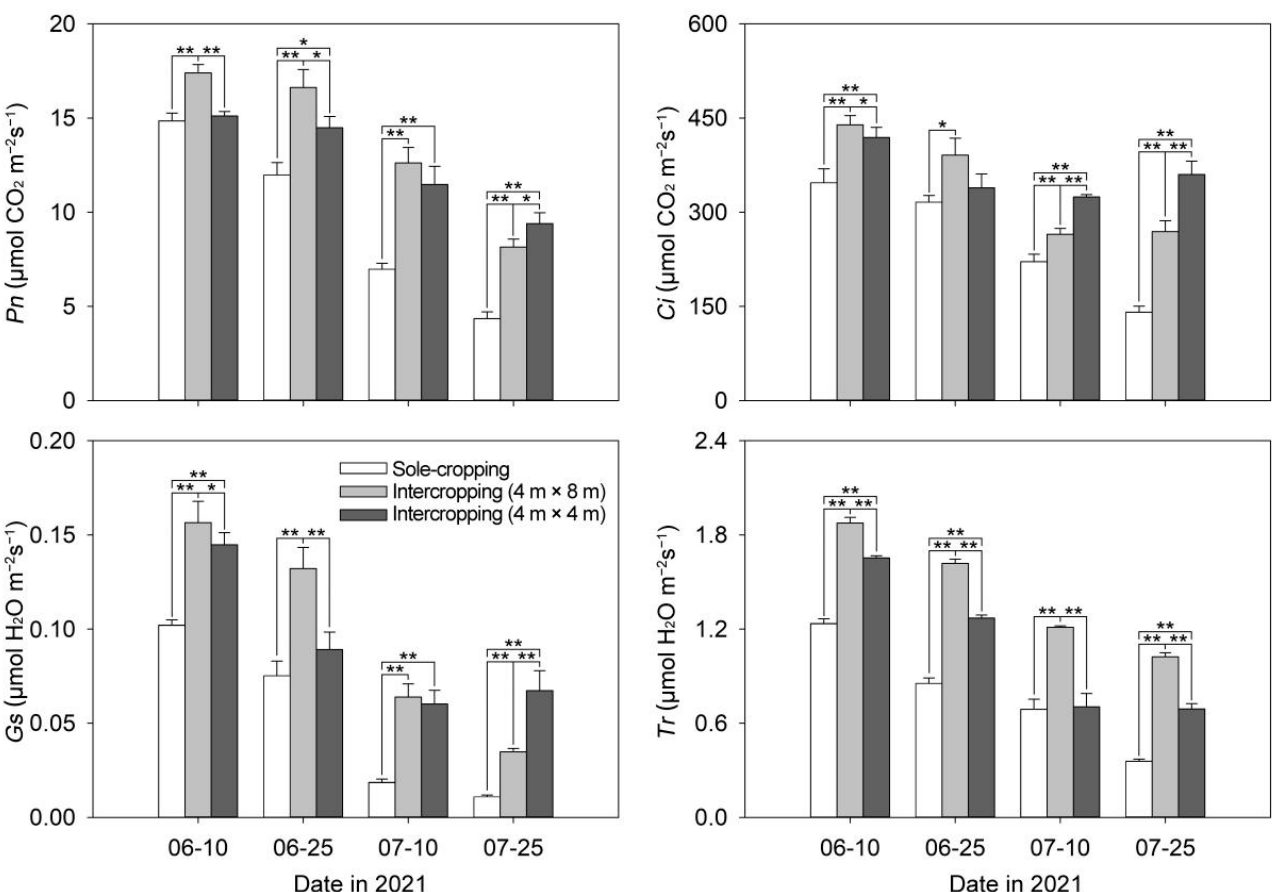
Figure 6. Effects of understory cultivation on photosynthetic characteristics of P. ostii . Values represent mean ± SDs, and * or ** indicate significantly lower or higher among the sole-cropping P. ostii and intercropping P. ostii under C. illinoinensis with row spacing of 4 m × 8 m and of 4 m × 4 m according to Duncan’s multiple range test (* p < 0.05, ** p < 0.01).